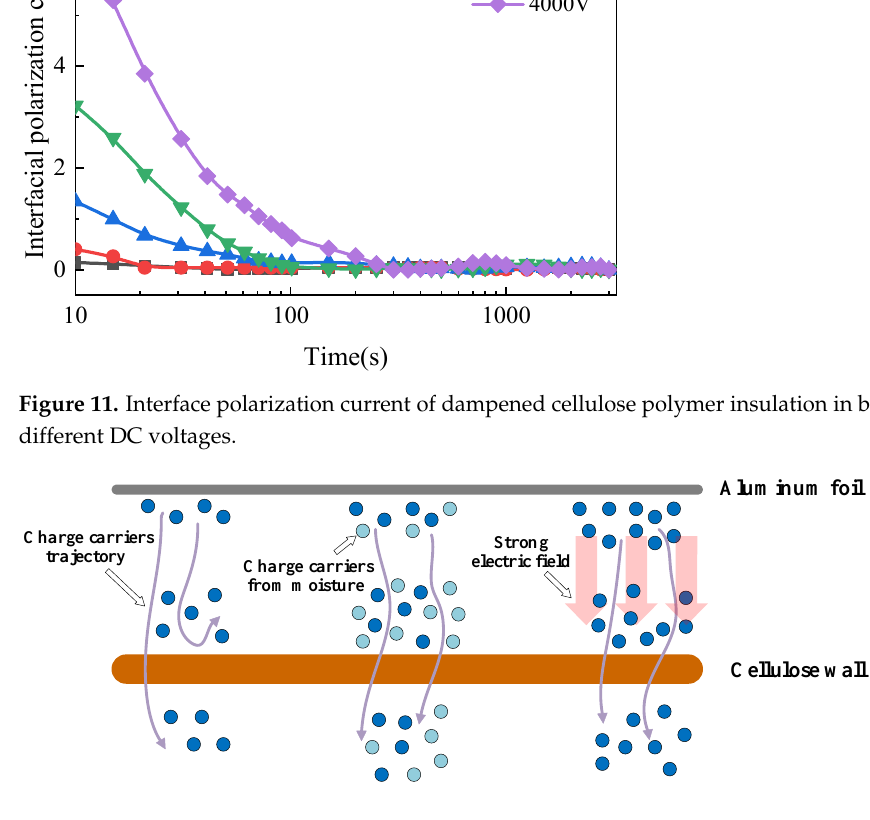
Figure 12. Migration process of charge carriers at the cellulose polymer interface.